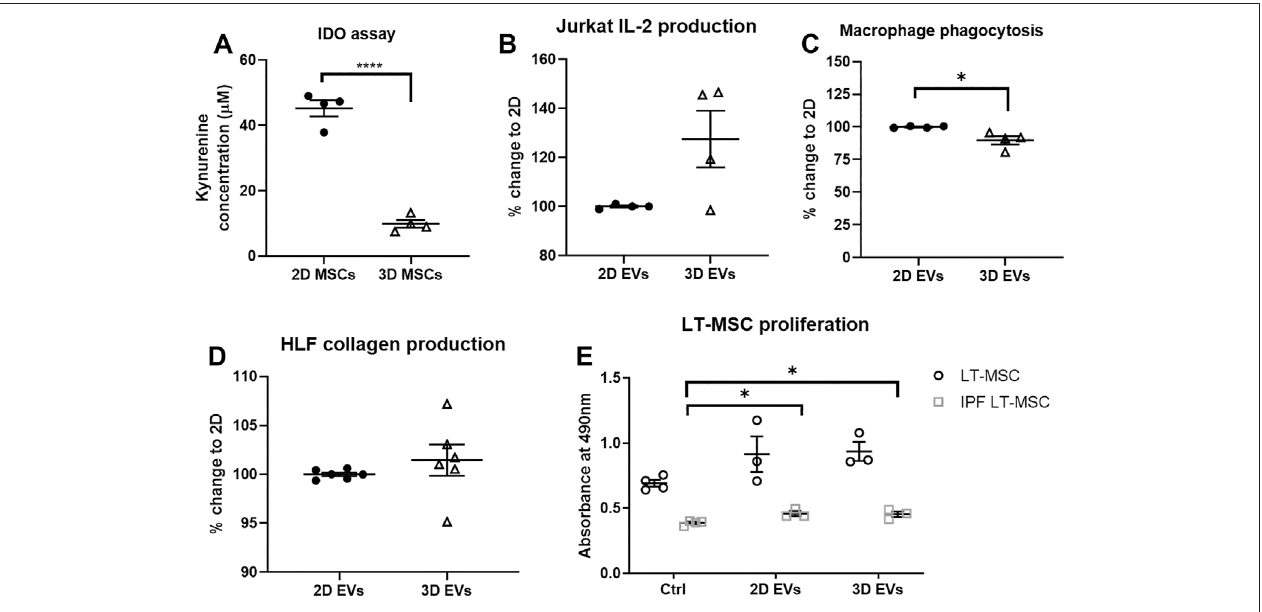
FIGURE 3 | In vitro functional assays to test MSC functions following 2D and 3D cultures. (A) IDO enzyme activity. (B) Changes in IL-2 production by Jurkat cells. (C) Changesinmacrophagephagocyticactivity. (D) ChangesincollagendepositionuponTGF- β 1activationonhumanlung fi broblast(HLF)cultures. (E) HealthyandIPF LT-MSCproliferation.Unpaired t -testusedfor (A – D) andone-wayANOVAfollowedbyTukey ’ sposthoctestformultiplecomparisonsfor (E) ,* p < 0.05,** p < 0.01,*** p < 0.001. All data are shown as mean ± SEM from n = 4-6 biological replicate measurements.